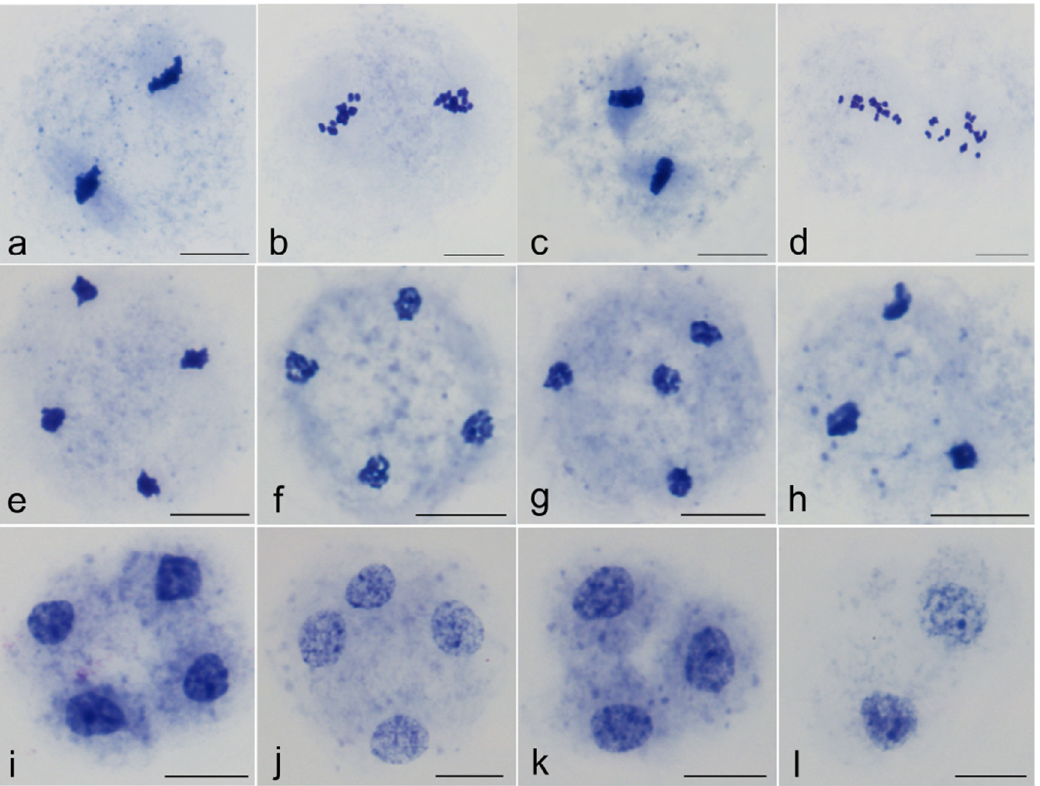
Figure 5. Observation of abnormal meiotic division of microspore mother cells. ( a – d ) Metaphase II showed parallel spindles, perpendicular spindles, ‘Eight-type’ spindles (tripolar spindle), and fused spindles, respectively. ( e , f ) Telophase II formed by parallel spindles. ( g ) Telophase II formed by perpendicular spindles. ( h ) Telophase II formed by tripolar spindles. ( i ) ‘Matts -type’ tetrads as a result of parallel spindle formation. ( j ) ‘Cross-type’ tetrads as a result of perpendicular spindle formation. ( k ) Triads as a result of tripolar spindle formation. ( l ) Dyads as a result of fused spindle formation. Scale bar = 10 µ